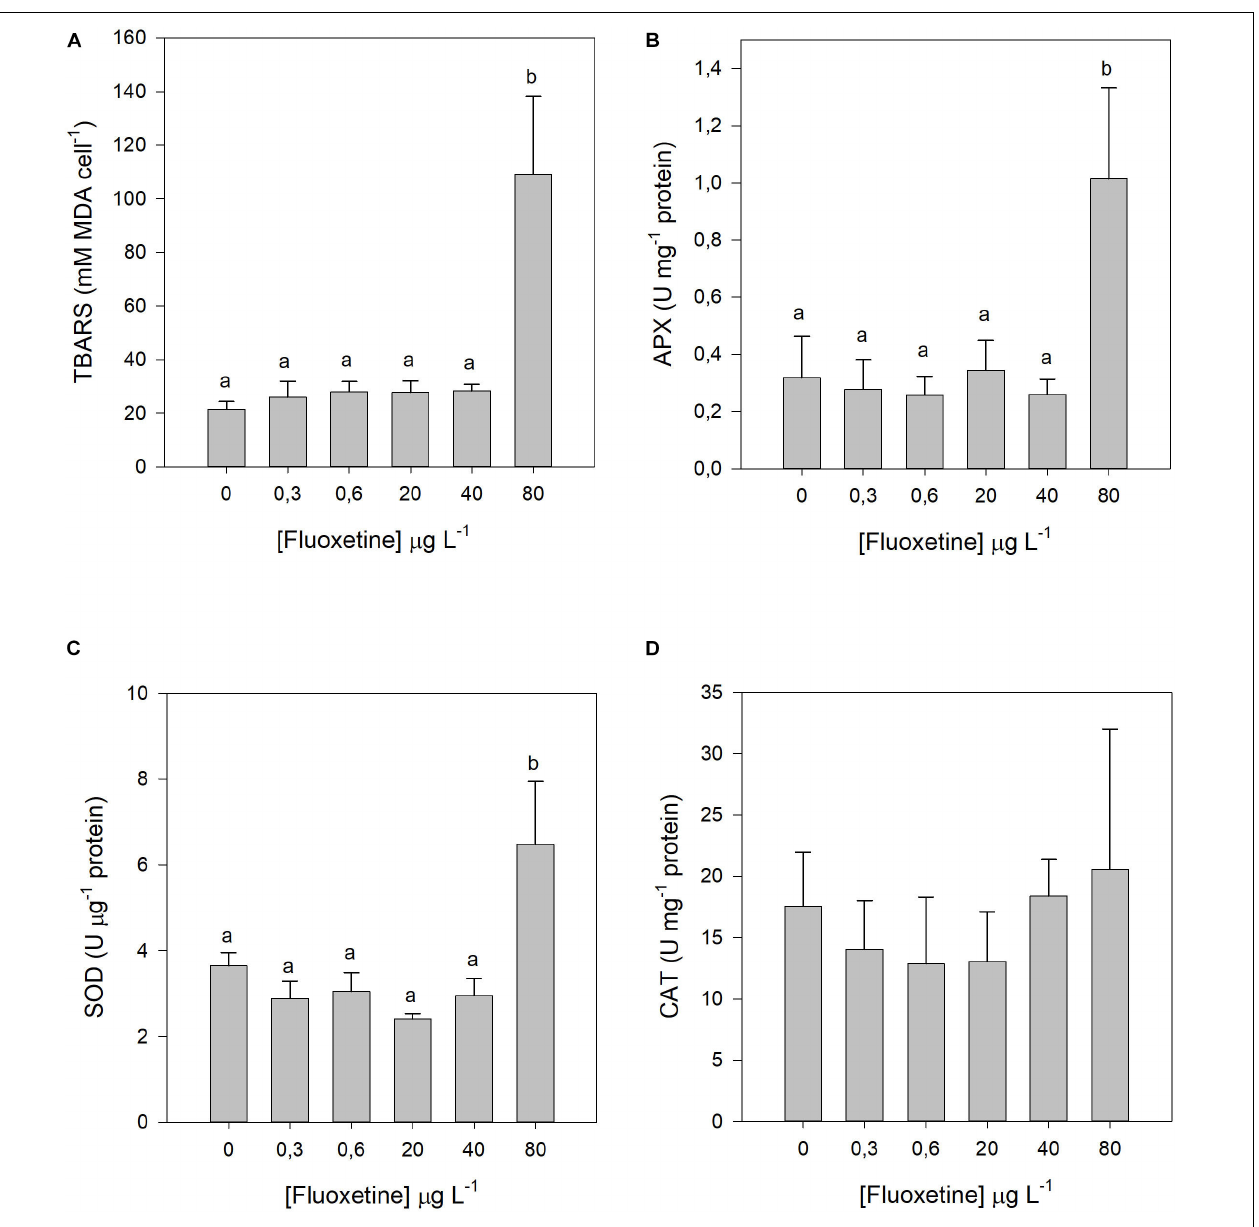
FIGURE 6 | Lipid peroxidation products and antioxidant enzymatic activities of Phaeodactylum tricornutum cells following a 48 h exposure to different fluoxetine concentrations. (A) Lipid peroxidation products (TBARS). (B) Ascorbate peroxidase (APX). (C) Superoxide dismutase (SOD). (D) Catalase (CAT). Average ± standard deviation, N = 3, different letters indicate significant differences at p <